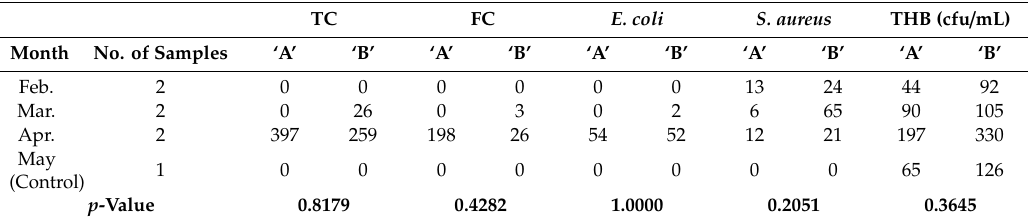
Table 5. Bacteria counts isolated from the two studied swimming pools with their significant values ( p -values). ‘A’ and ‘B’ represent the two di ff erent swimming pools. TC FC E. coli S. aureus THB (cfu / mL) Month No. of Samples ‘A’ ‘B’ ‘A’ ‘B’ ‘A’ ‘B’ ‘A’ ‘B’ ‘A’ ‘B’ Feb. 2 0 0 0 0 0 0 13 24 44 92 Mar. 2 0 26 0 3 0 2 6 65 90 105 Apr. 2 397 259 198 26 54 52 12 21 197 330 May 1 0 0 0 0 0 0 0 0 65 126 (Control) p -Value 0.8179 0.4282 1.0000 0.2051